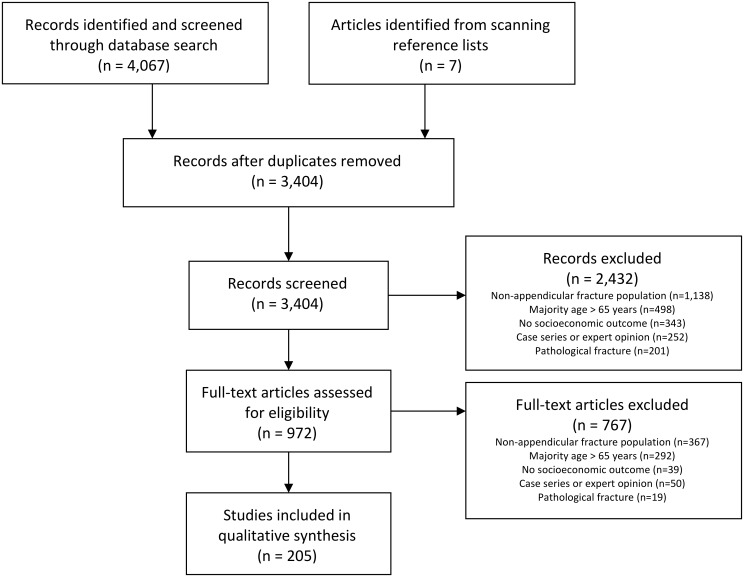
PRISMA flow chart.